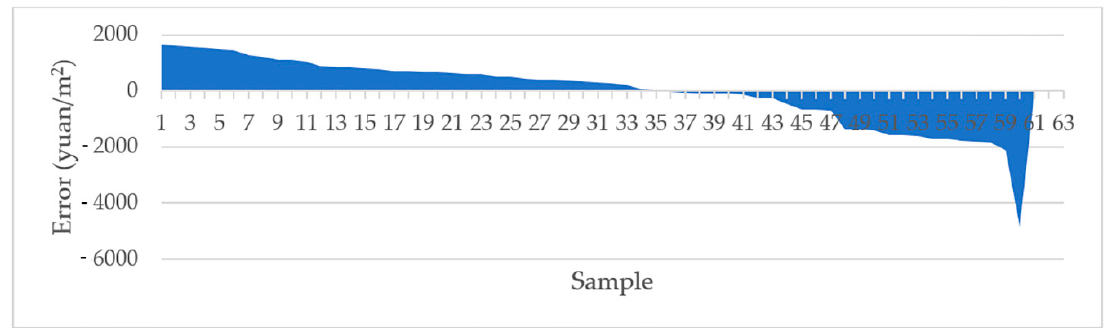
Figure 10. Leave ‐ one ‐ out cross ‐ validation (LOOCV) results of the 3D model. Figure 10. Leave-one-out cross-validation (LOOCV) results of the 3D